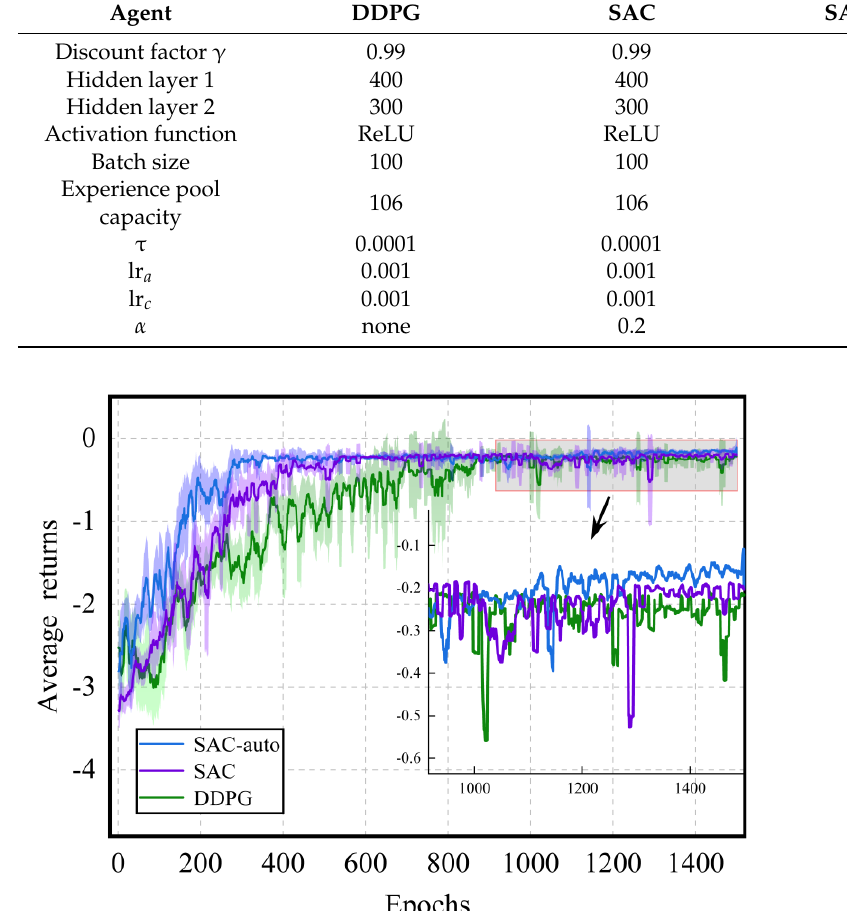
Figure 8. Training process.